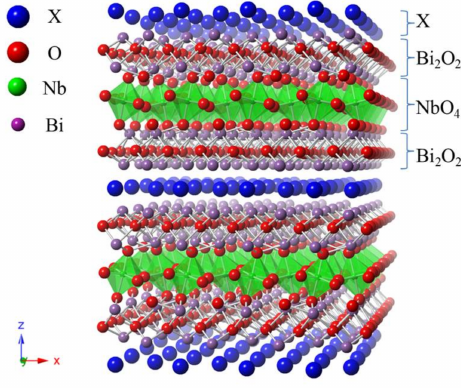
Figure 1. Crystal structure of Sill é n–Aurivillius type perovskite Bi 4 NbO 8 X (X = Cl, Br). The purple, red and blue balls denote Bi, O and X atoms, respectively. Nb-centered octahedra are shown in